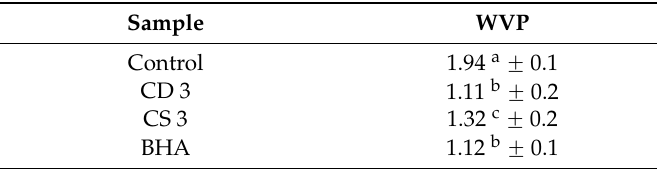
Table 2. Water vapour permeability (WVP) of the different gelatine